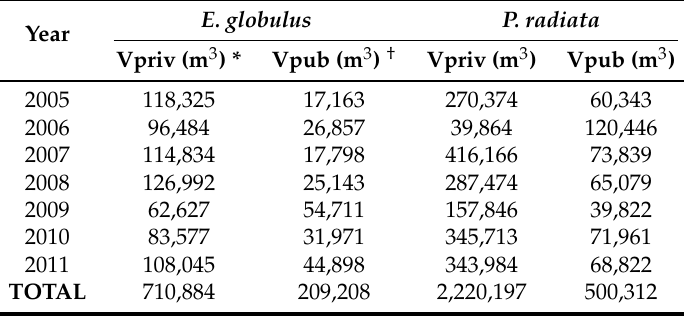
Table 4. P. radiata and E. globulus cuttings carried out in Biscay between 2005 and 2011.